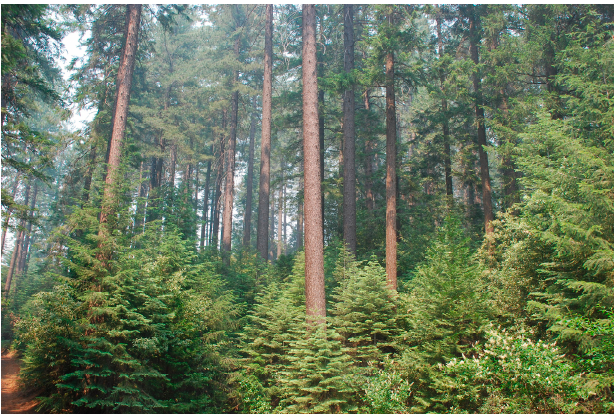
Figure 3. A fire-suppressed mixed-conifer stand in the Sierra Nevada region of northern California. The overstory is dominated by sugar pine and ponderosa pine. The stand contains a dense understory of shade tolerant, fire sensitive white fir, and incense cedar.